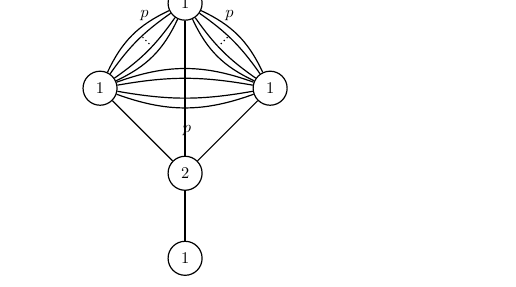
Figure 32 . 3d mirror for a class S SCFT which is obtained by compactifying the 6d A 2 theory on a Riemann sphere with an irregular puncture and a regular maximal puncture. The gauge group is obtained by factoring out an overall U(1) , which can be implemented by ungauging any one of the U(1) gauge